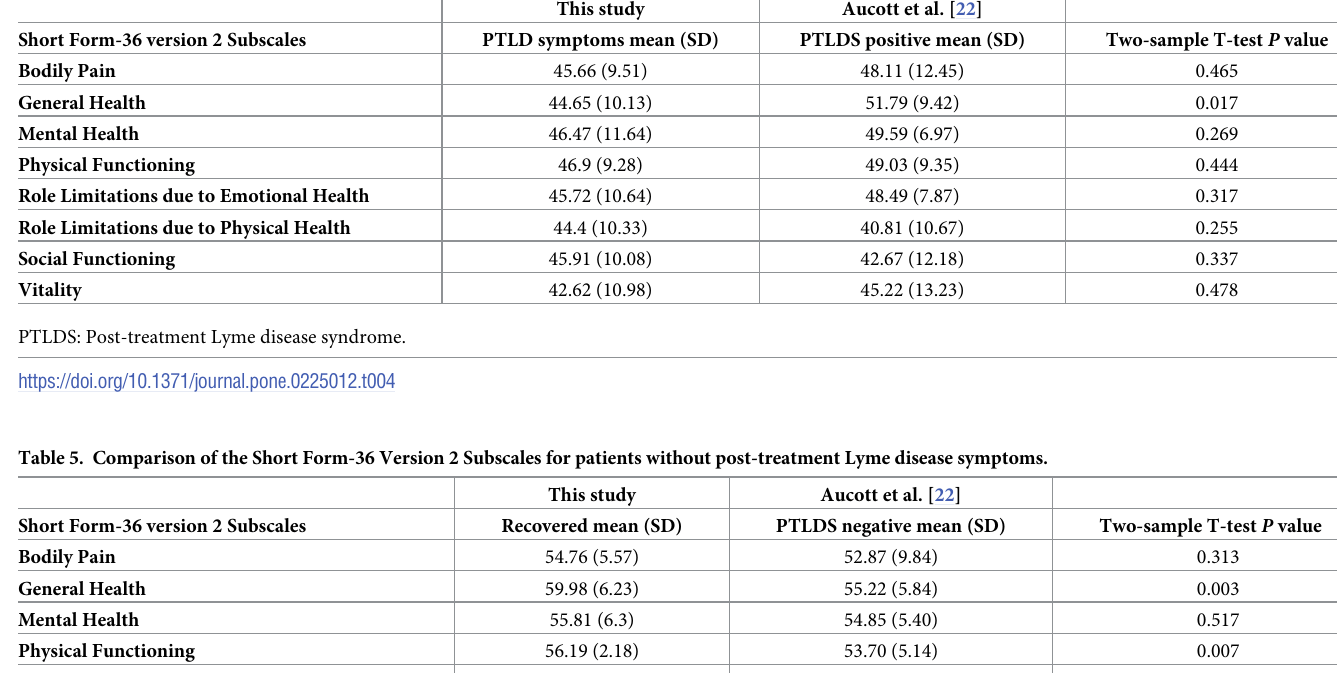
Table 4. Comparison of the Short Form-36 Version 2 Subscales for patients with post-treatment Lyme disease symptoms. This study